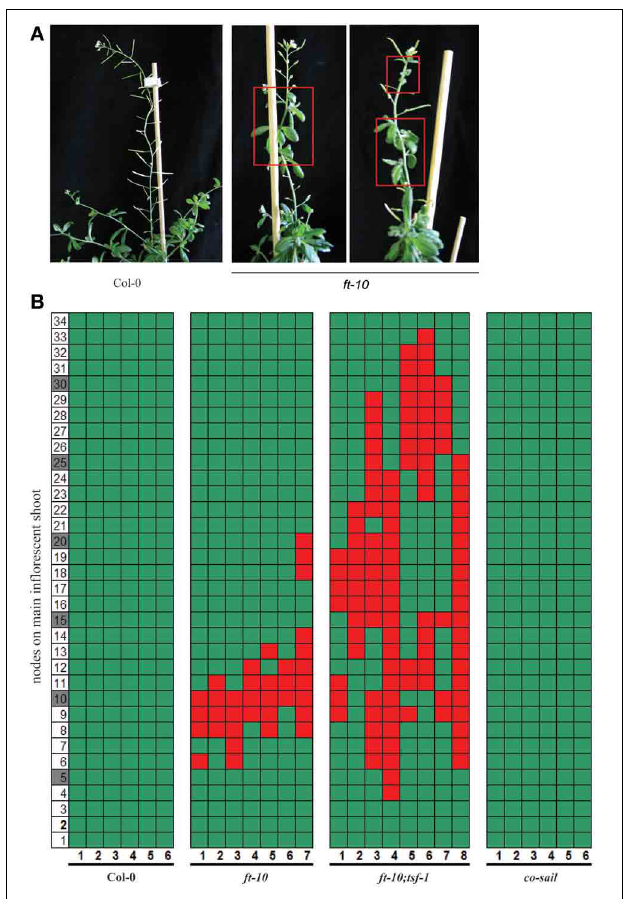
FIGURE 2 | Reversion phenotype of photoperiod pathway mutants in SDs. Plants were grown under SD conditions. (A) Plants typical for flowering phenotype of Col-0 wildtype and ft-10 mutant (B) Side shoots on the main inflorescence were counted from the first flower (1) toward the top (until node 34). Flowers are indicated by green, cauline leaves by red squares, the number of plants assessed is indicated on the